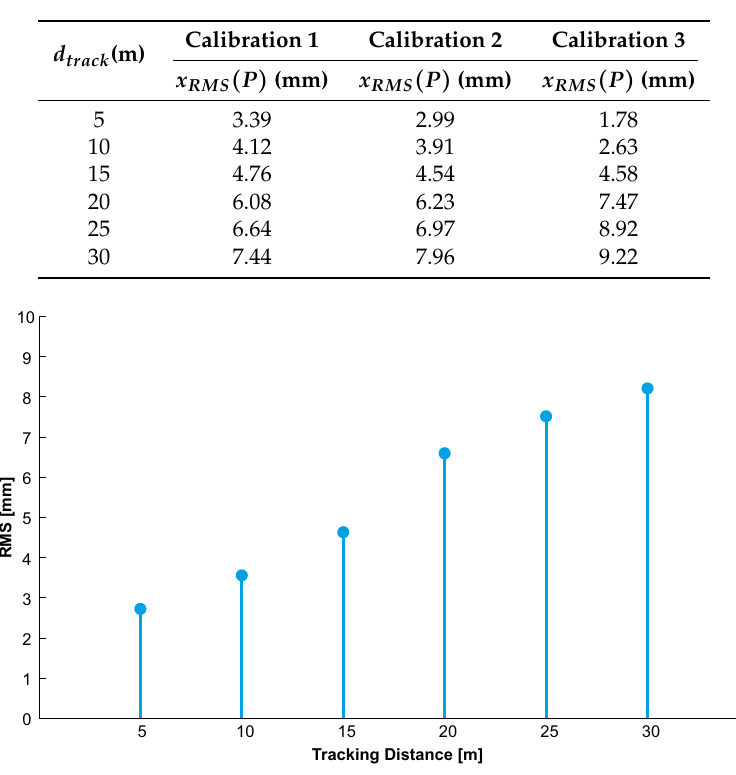
Table 1. Relative accuracy x RMS ( P ) of three independent calibrations.